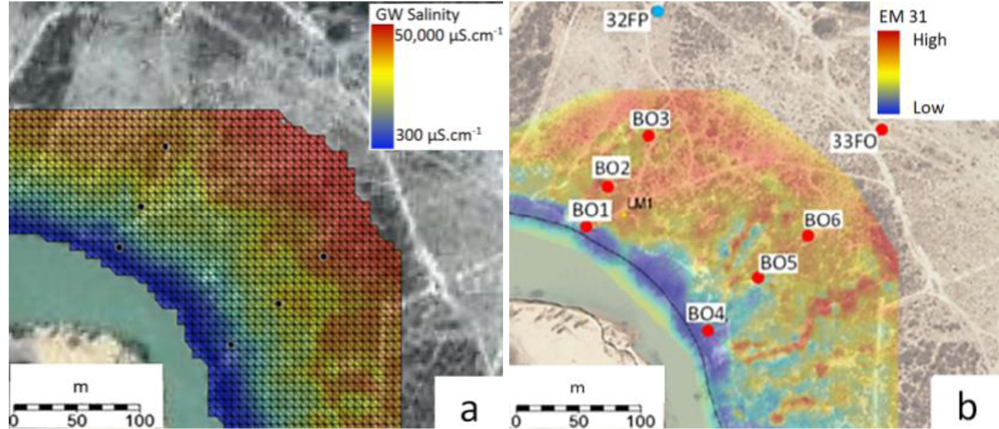
Fig. 6. Simulated solute concentration distribution (a) and EM31 survey (Berens et al., 2009) (b) in November 2007 at the study site.